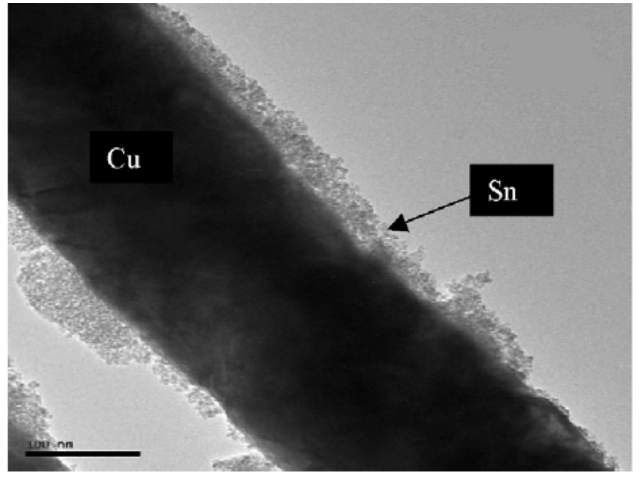
Figure 10. TEM image of a single Sn-covered Cu nanopillar (5 min tin deposition). Adapted from [176]. Copyright 2009